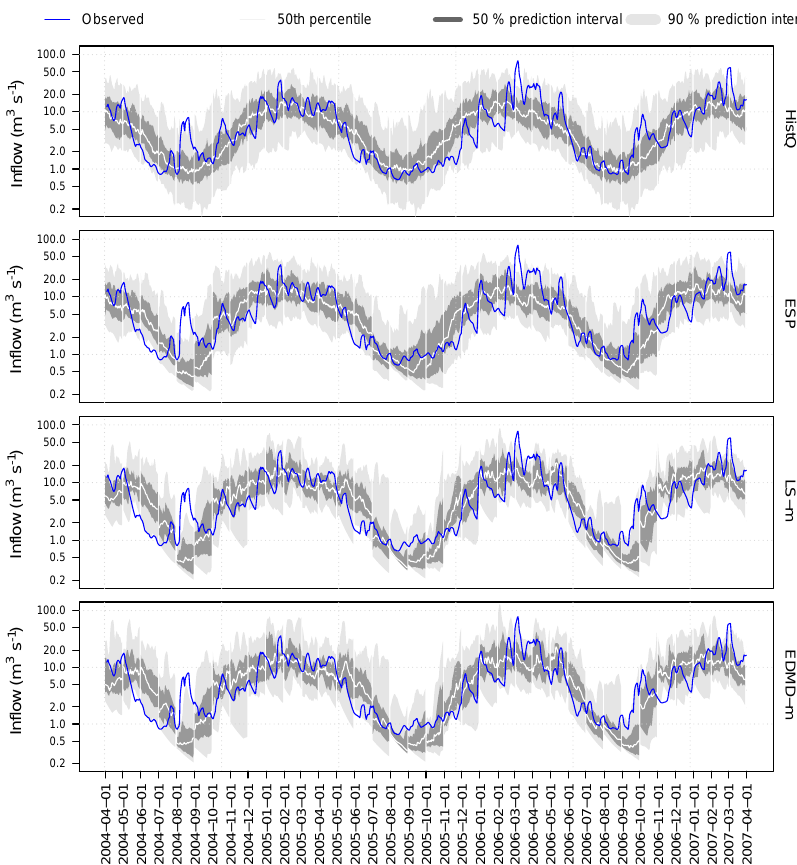
Figure 15. Hydrographs obtained with historical streamflow, ESP, seasonal forecasts corrected with LS-m and seasonal forecasts corrected with EDMD-m in catchment 7 from 1 April 2004 to 1 April 2007. The vertical axis is logarithmic. The blue line represents the observed streamflow. The grey shaded areas present the forecasts issued in the previous month, i.e. 31–60 days prior to the